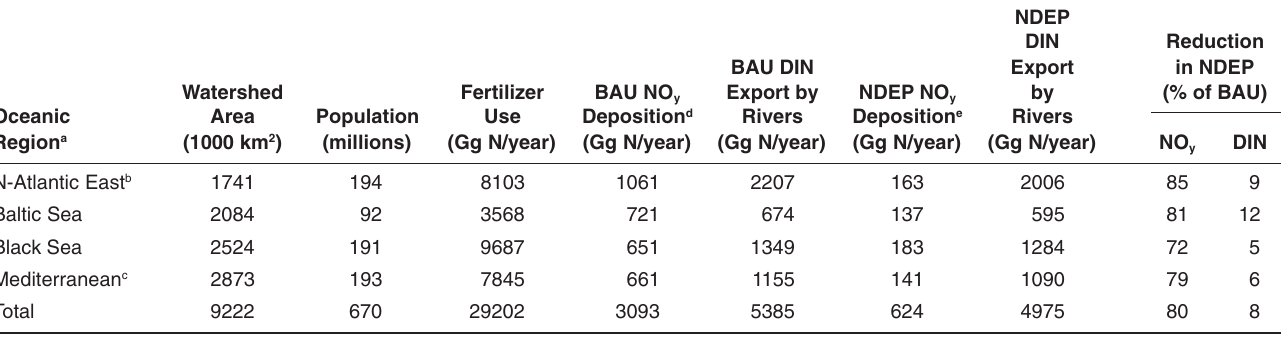
Inputs to N-Model (Watershed Area, Population, Fertilizer Use, and NO and Calculated DIN Export Rates for European Rivers for a BAU Scenario and NDEP Scenario for 2050. Based on Domingues (2001)[14]; See Text for Scenario